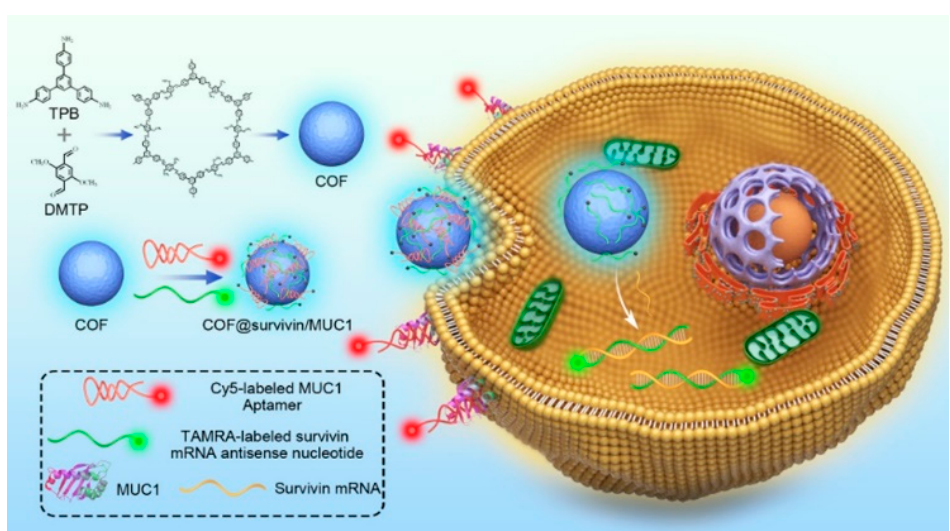
Figure 4. Synthesis of COF and the multicolor nanoprobe, and its schematic application in cell imaging. Reprinted with permission from [63]. Copyright 2021 American Chemical Society.